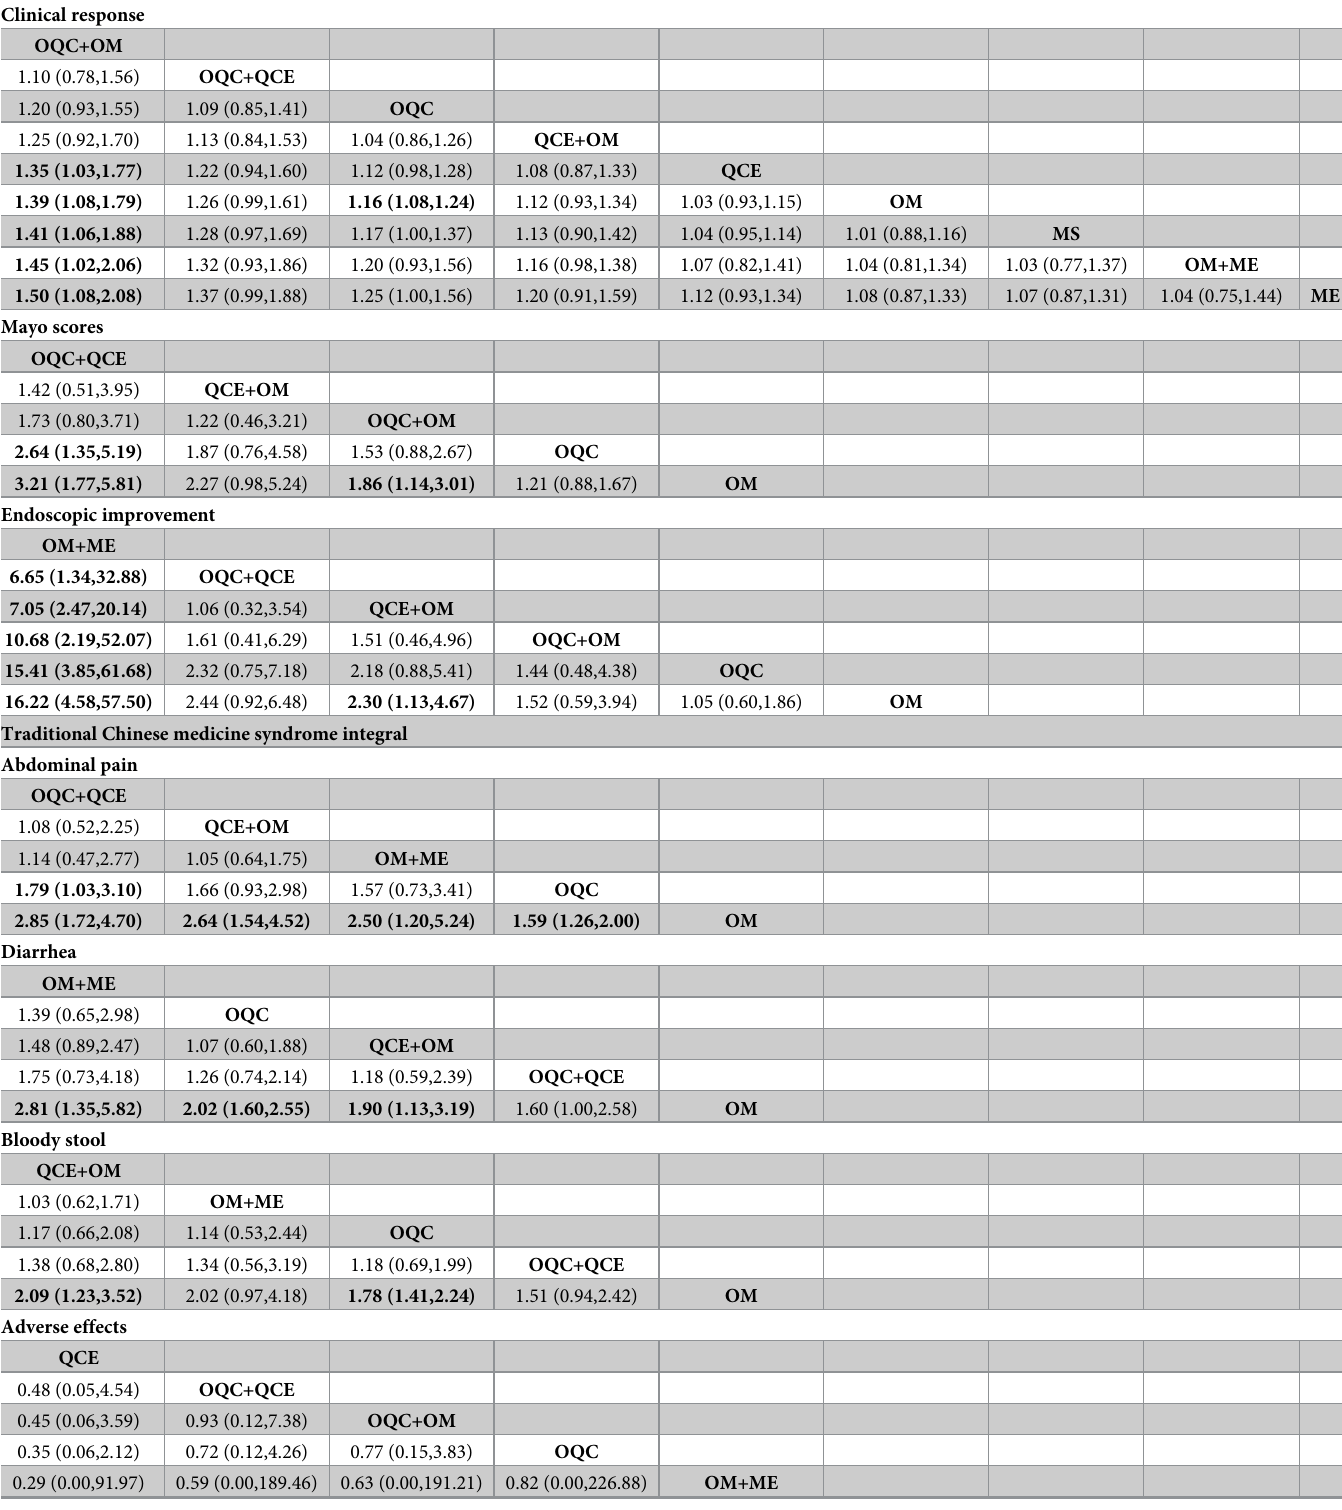
Table 2. Risk ratio (RR) or standard mean difference (SMD) with 95% confidence interval (CI) of different outcomes. Clinical